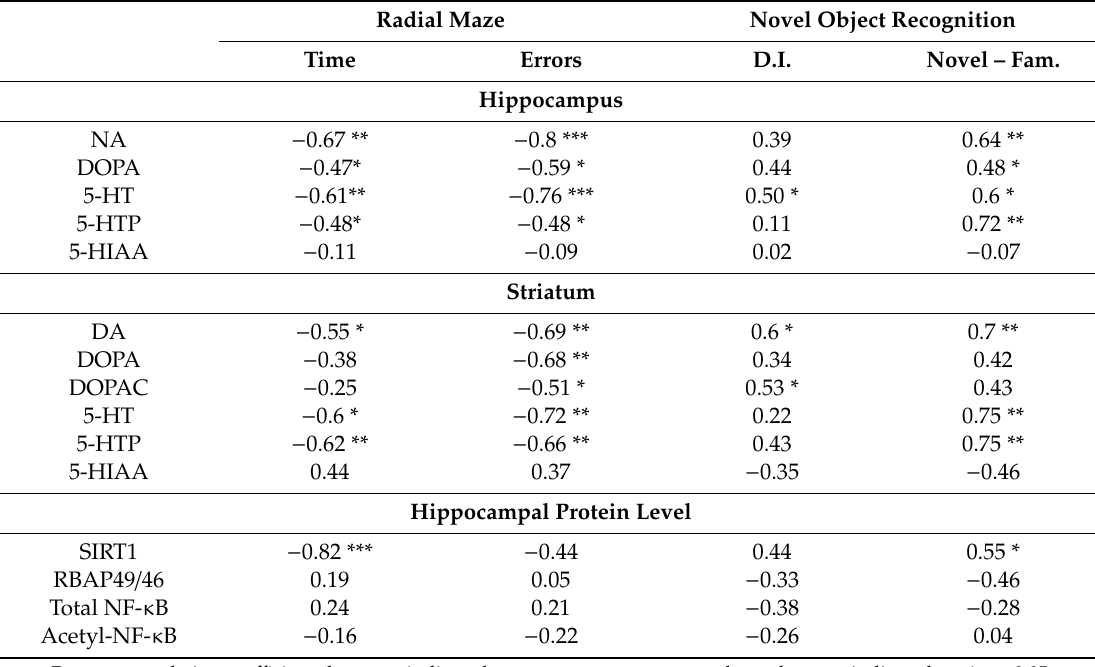
Table 1. Correlation analysis between behavioral results at the end of the chronic treatments and neurochemical / protein levels detected in old animals. Radial Maze Novel Object Recognition Time Errors D.I. Novel –